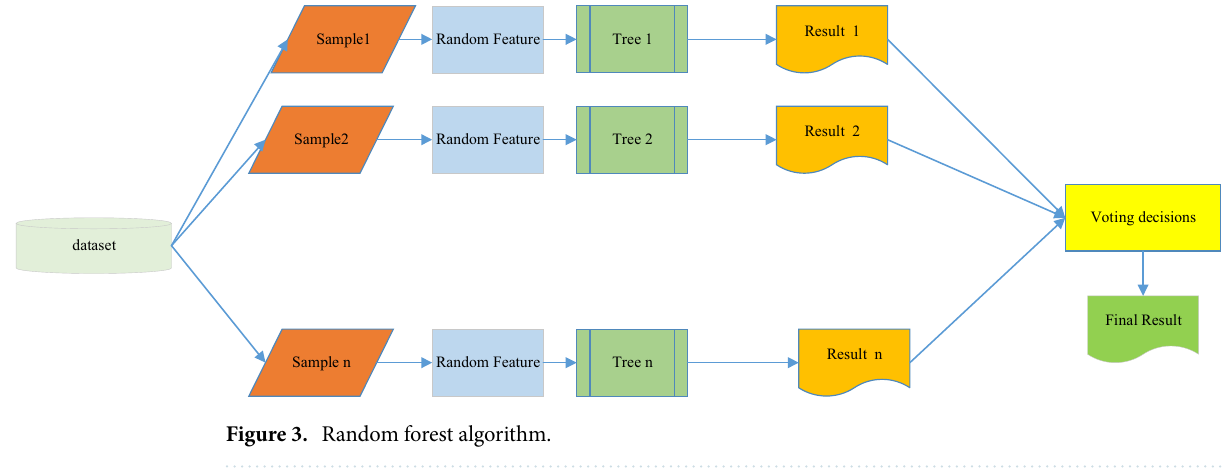
Figure 3. Random forest algorithm.